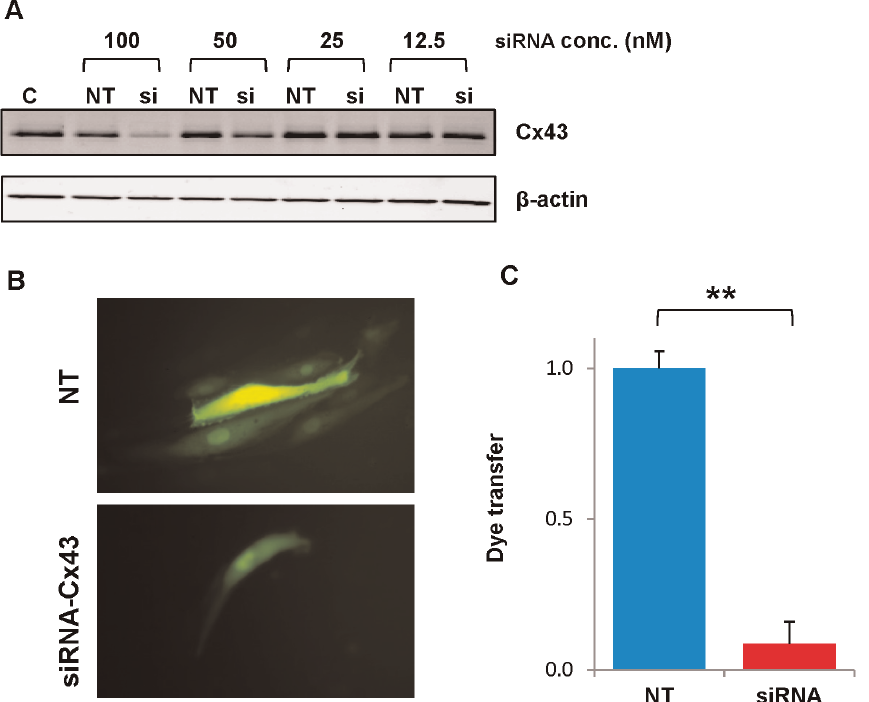
Figure 8. Transfection with siRNA effectively reduces expression and function of Cx43 in HPAECs. Cultures of HPAECs were transfected with Cx43 or control (non-targeting) siRNA 48 hrs prior to various analyses. A.) Western Blots show levels of Cx43 in untreated HPAECs (C) or in cells transfected with different concentrations of non-targeting (NT) or Cx43 (si) siRNA. B.) Fluorescence microscope images show HPAECs micro-injected with Lucifer yellow after transfection with non-targeting (NT) or Cx43 (siRNA-Cx43) siRNA. C.) Graph shows the degree of dye transfer in cultures of HPAECs microinjected with Lucifer yellow after transfection with non-targeting (NT) or Cx43 (siRNA-Cx43) siRNA. Dye transfer was normalized by dividing the number of dye containing neighbors by the average value obtained in NT transfected controls. **, p , 0.001, n=6 for each group.